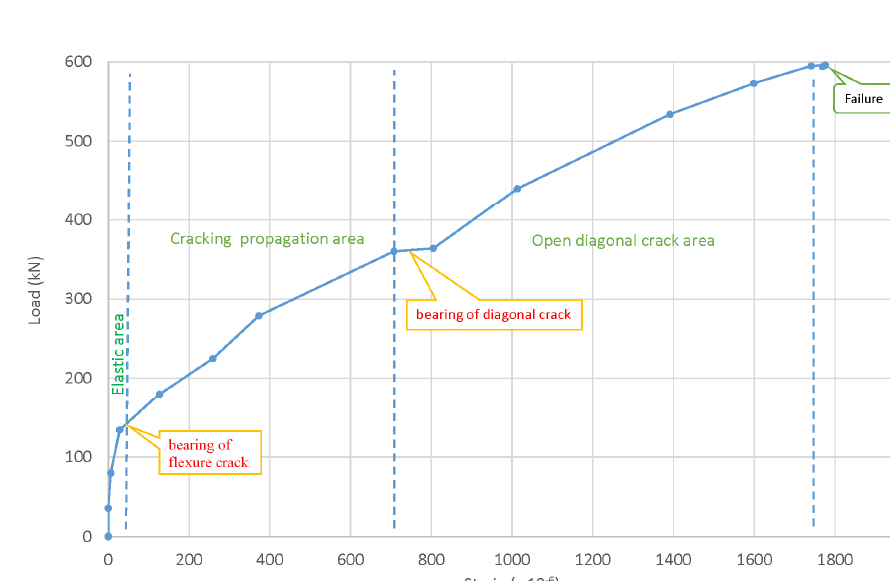
Figure 3: Mechanical behavior of reinforced concrete corbel C0, strain of tensile steel